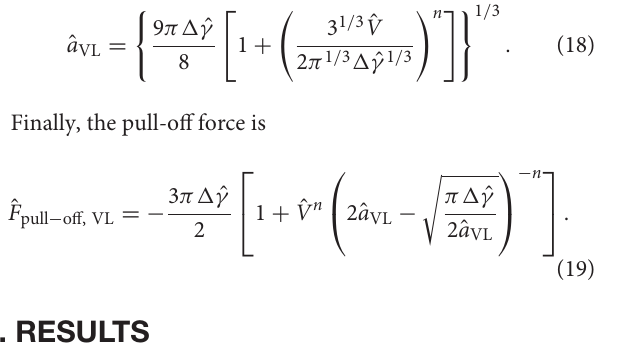
Frontiers in Mechanical Engineering |